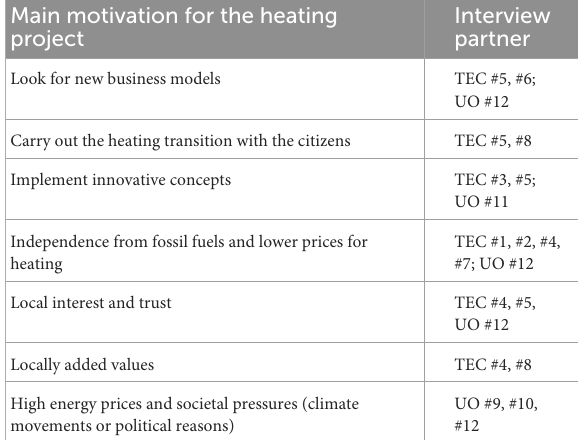
TABLE 3 Overview of motivational